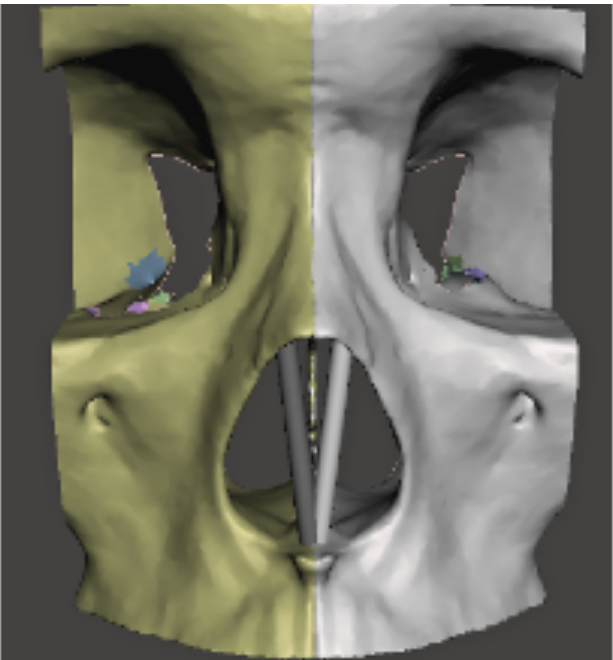
Figure 5. Addition of bilateral support rods.